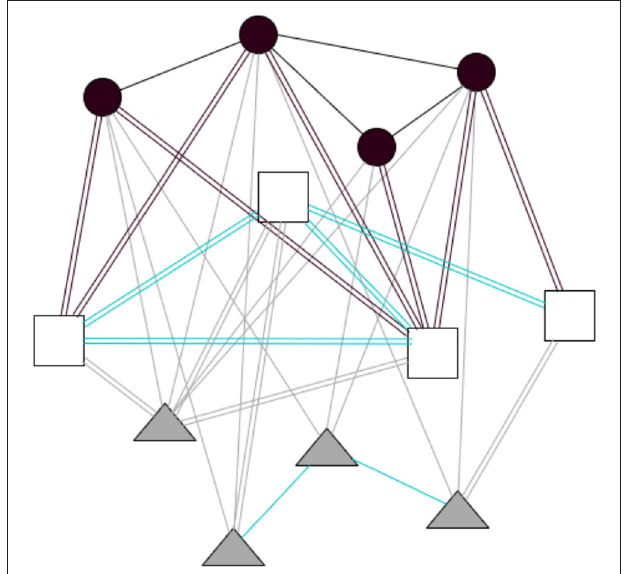
FIGURE 1 | A socio-material network based on Basov (2018). Circles, actors; Triangles, analog objects; Squares, digital objects; Black lines, social ties; Cyan lines, material links; Gray lines, usage of analog objects; Black double lines, usage of digital objects; Cyan double lines, digital links; Gray double lines, analog/digital